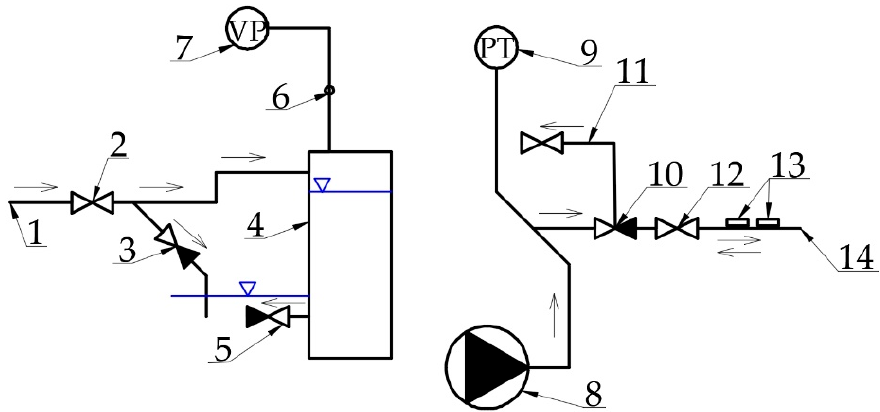
Figure 7. Scheme of pumping station PS_1 (numbering as in Figure 4).